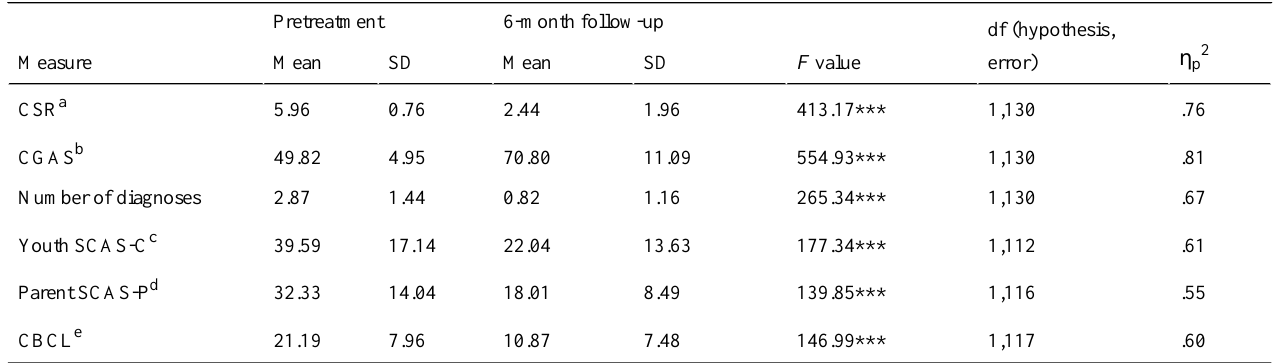
Table 1. Treatment outcomes for children and adolescents with at least one anxiety disorder assessed in study 2.